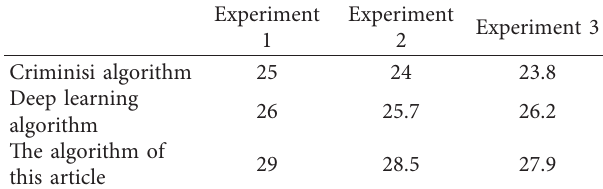
Table 1: Comparison of PSNR effects of three repair